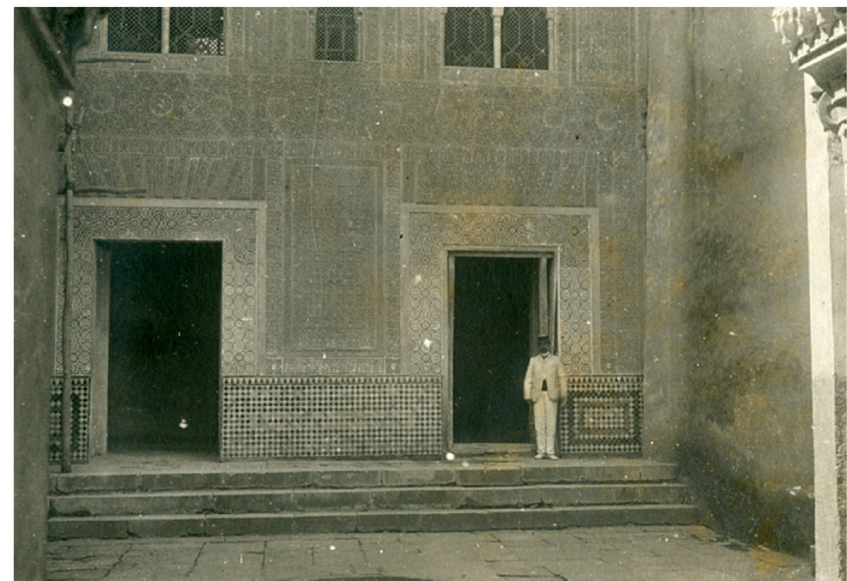
Figure 29. Facade of the Comares Palace showing ceramic dadoes of a similar design to those in the Cuarto Dorado. Photograph by Paul Riches, August 1903. © Archivo del Patronato de la Alhambra y Generalife, Photograph Collection,